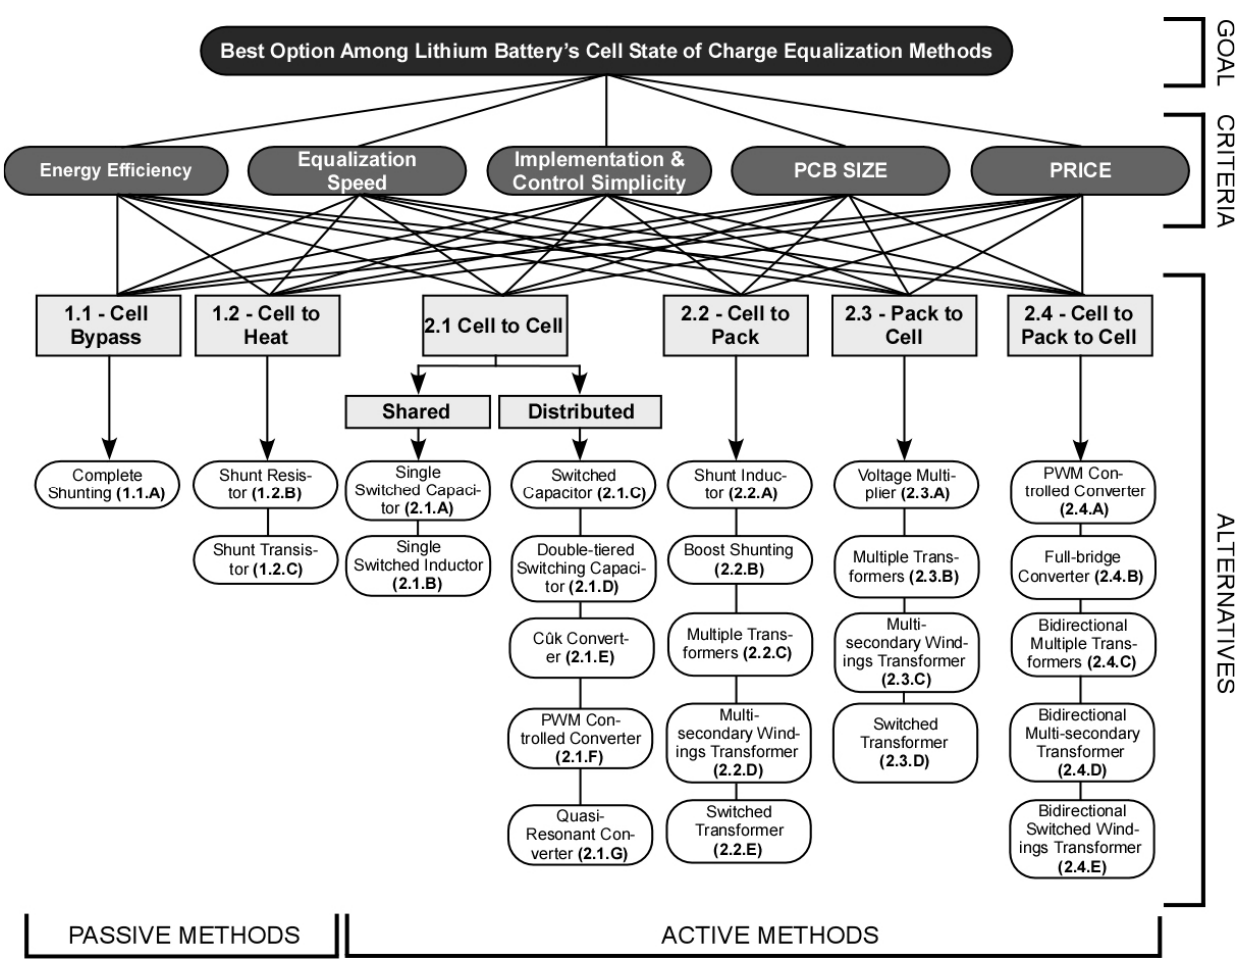
Figure 1. State of Charge Equalization Methods classified according to the energy transfer configuration. 1.1 Cell Bypass (CB), 1.2 Cell-to-Heat (CH), 2.1 Cell-to-Cell Shared (CCS), 2.1 Cell-to-Cell Distributed (CCD), 2.2 Cell-to-Pack (CP), 2.3 Pack-to-Cell (PC) and 2.4 Cell-to-Pack-to-Cell (CPC).